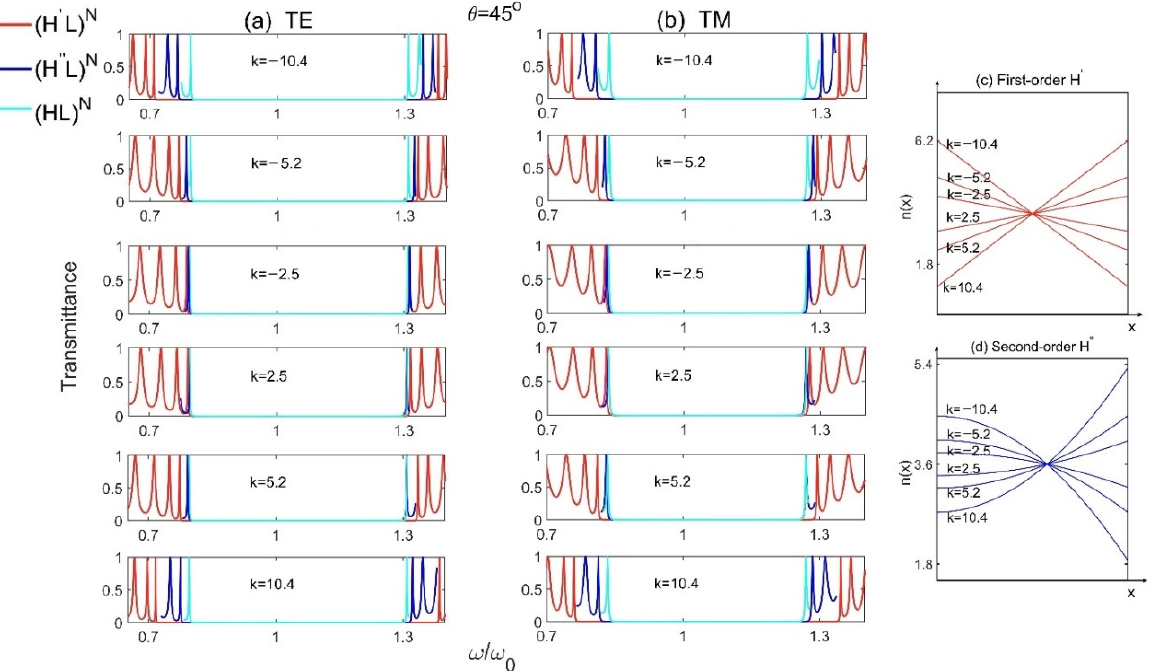
Figure 4. The transmission spectra of Model 1 ( H (cid:48) L ) N , Model 2 ( H (cid:48)(cid:48) L ) N and the reference Model ( HL ) N for different slopes k at incident angle θ = 45 ◦ for ( a ) TE and ( b ) TM polarizations, and ( c , d ) are the distributions of refractive index for different slopes k for the first- and second-order gradient material H (cid:48) and H (cid:48)(cid:48) ,